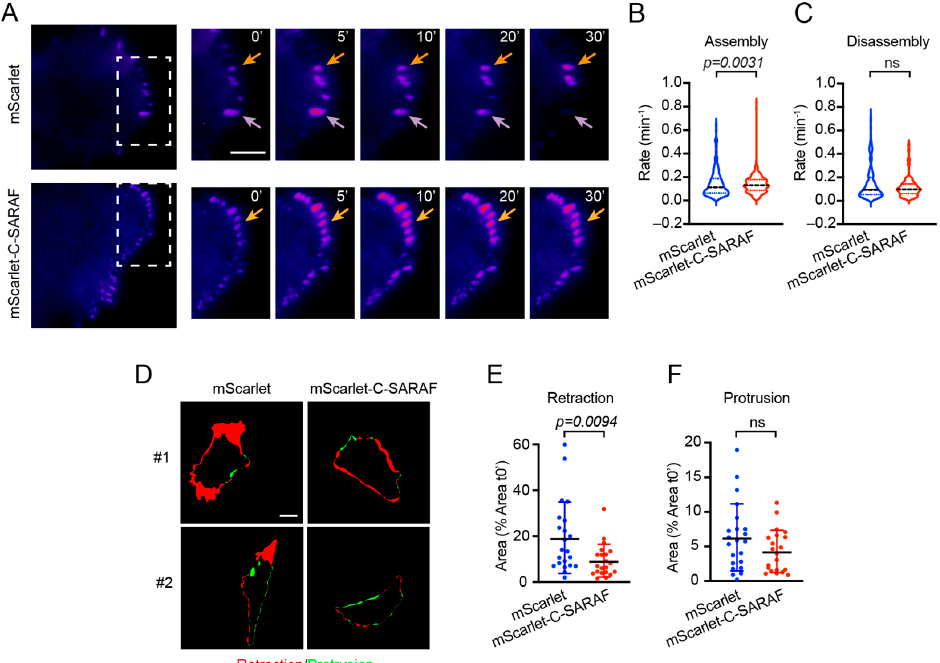
Figure 4. The C-terminal fragment of SARAF increases the rate of assembly of focal adhesions and reduces cell retraction. ( A ) Representative time-lapse imaging of EGFP-Paxillin from MDA-MB-231 cells co-expressing mScarlet or mScarlet-C-SARAF. Assembling FAs are marked with orange arrows, while purple arrows mark assembling and disassembling focal adhesions. Scale bar = 5 µm. Quantification of assembly ( B ) and disassembly rates ( C ) of FAs from recordings of EGFP-Paxillin transfected MDA-MB-231. ( D ) Representative images from two cells per condition of retraction (red) and protrusion (green) of MDA-MB-231 cells observed in ( A ). Quantification of retraction ( E ) and protrusion ( F ) cell area. Scale bar = 20 µm. Bars represent average response. Individual points represent the response of each cell. Bar represents the average of individual points. Error bars correspond to standard deviation. Mann–Whitney’s non-parametric t -test was applied to define statistical significance.